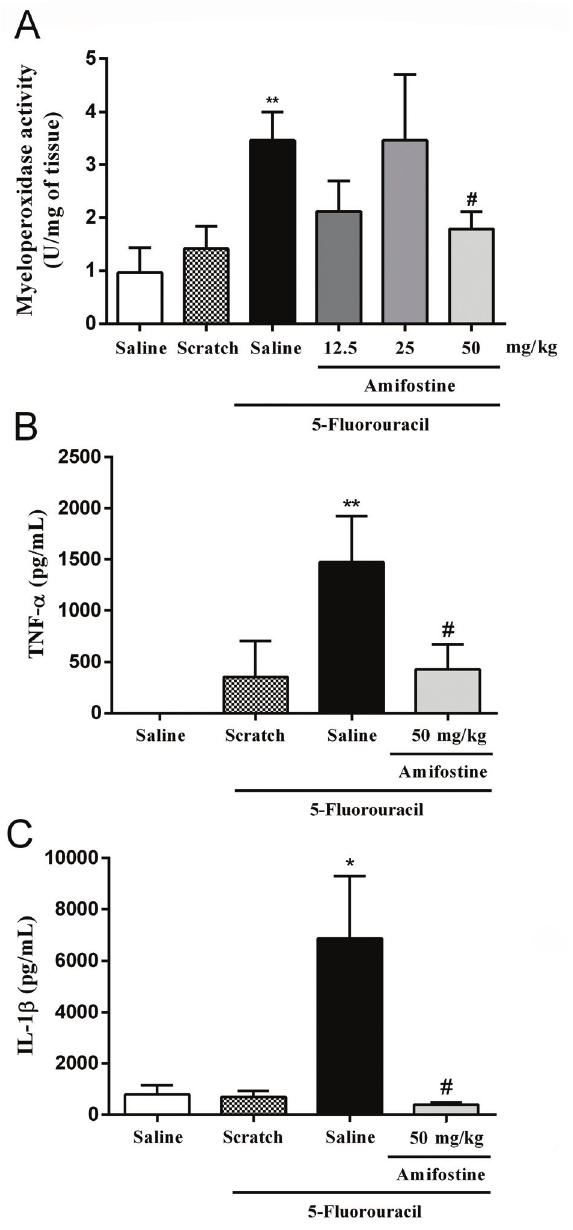
Figure 4. 5- fl uorouracil (5-FU)-induced in fl ammation was abol- ished in amifostine-treated animals. The proin fl ammatory effect of 5-FU upon the cheek pouch was detected as an increase in myeloperoxidase activity ( A ) and the production of tumor necrosis factor-alpha (TNF- a ) ( B ) and interleukin-1 beta (IL-1 b ) ( C ). Data are reported as means ± SE (n=6/group). *P o 0.05, **P o 0.01 vs group treated only with saline or scratch. # P o 0.05 vs 5-FU- treated